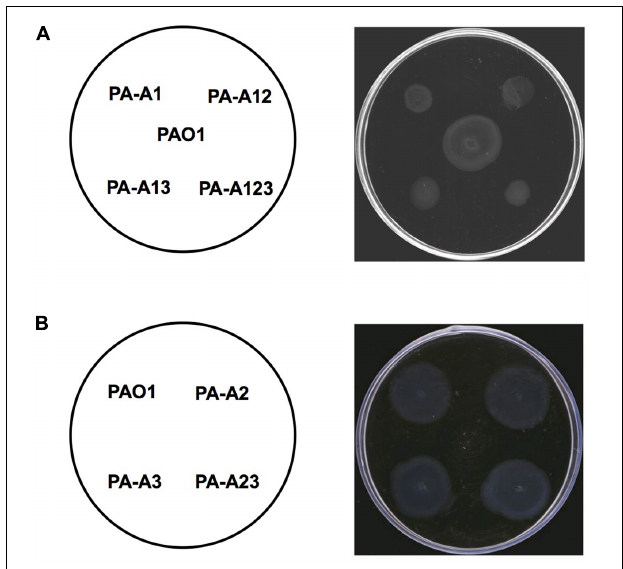
FIGURE 6 | Twitching motility of P. aeruginosa strains. (A) Twitching motility patterns of P. aeruginosa acpP1 mutant strains after incubation at 37 ◦ C for 24 h. PAO1, P. aeruginosa wild type strain; PA-A1, P. aeruginosa acp1 ::Ec acpP single mutant strain; PA-A12, P. aeruginosa acp1 ::Ec acpP acp2 ::Gm r double mutant strain; PA-A13, P. aeruginosa acp1 ::Ec acpP acp3 ::Gm r double mutant strain; PA-A123, P. aeruginosa acp1:: Ec acpP acp2:: Tc r acp3:: Gm r triple mutant strain. (B) Twitching motility patterns of P. aeruginosa acpPs mutant strains after incubation at 37 ◦ C for 24 h. PAO1, P. aeruginosa wild type strain; PA-A2, P. aeruginosa acpP2 ::Gm r single mutant strain; PA-A3, P. aeruginosa acpP3 ::Gm r single mutant strain; PA-A23, P. aeruginosa acp2 ::Tc r acp3 ::Gm r double mutant